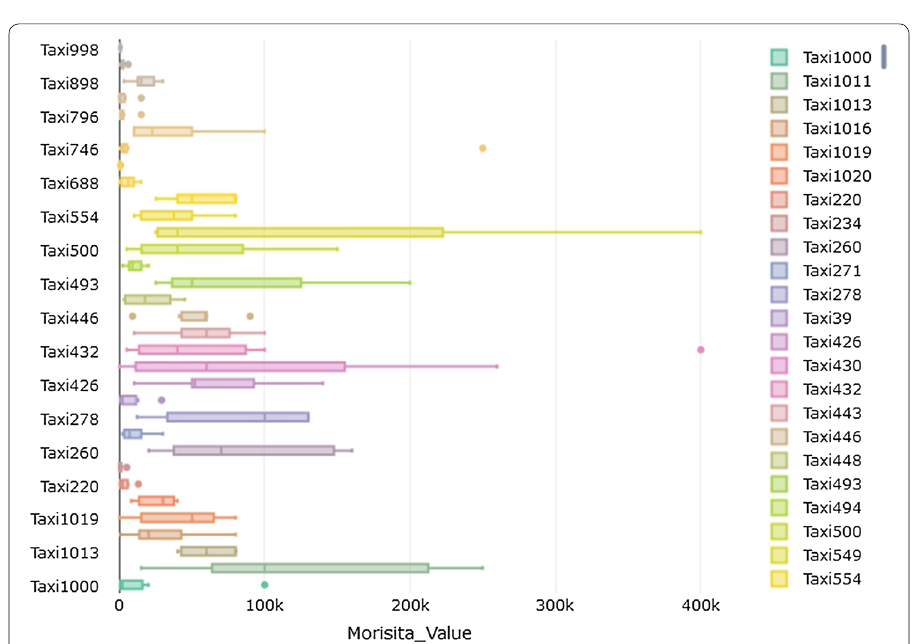
Fig. 9 Box plot about metadata of tracking records of 30 taxi